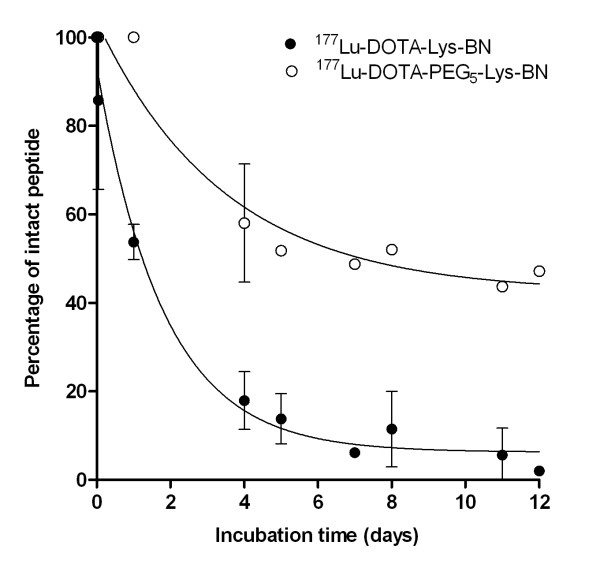
Metabolic stability of177Lu-DOTA-Lys-BN and177Lu-DOTA-PEG5k-Lys-BN in human plasma.